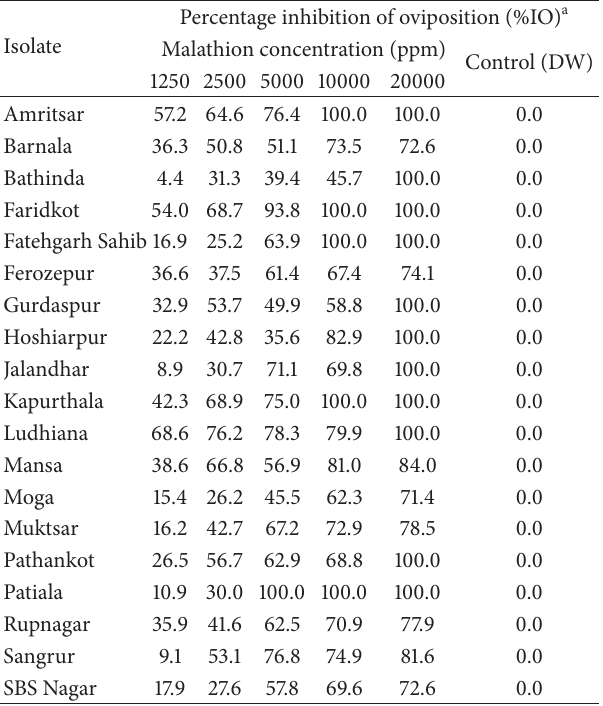
Table 4: Effect of malathion on %IO of different isolates of R. ( B. ) microplus